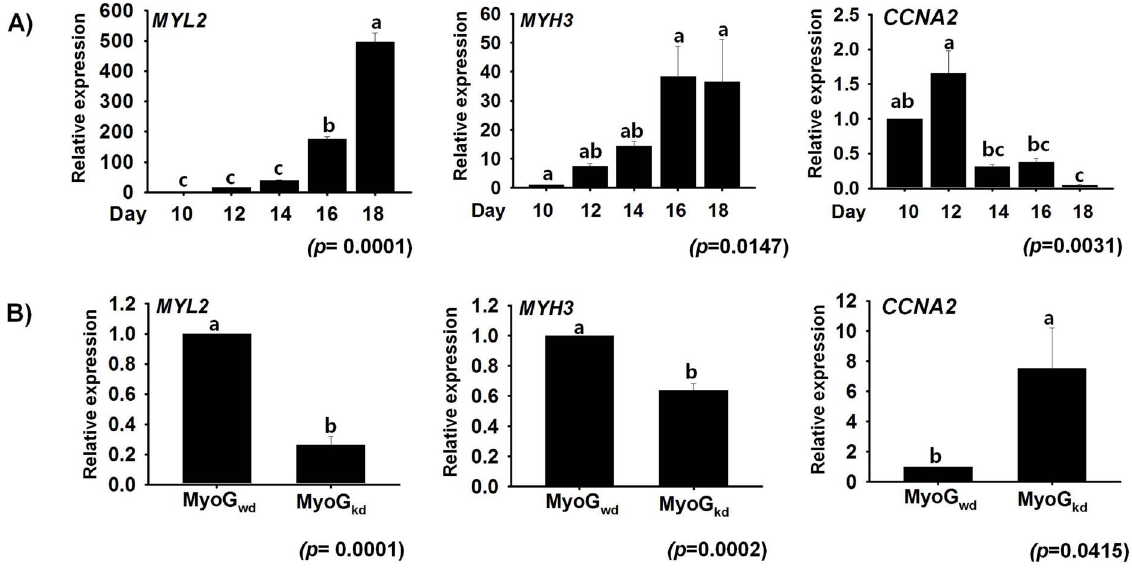
Figure 2. Effect of MyoG kd on MYL2 , MYH3 and CCNA2 genes. A ) Time course study of mRNA expression of MYL2 , MYH3 and CCNA2 during MSCs differentiation. Cells cultured in differentiation media showed gradual increase in MYL2 and MYH3 expression until Day 18, but transient increase of CCNA2 at day 12 decreased at later stage of myogenesis. B ) Evaluation of MYL2 , MYH3 , and CCNA2 gene expression by real time RT-PCR in MyoG kd cells. Decreased MYL2 and MYH3 gene expression and increased CCNA2 expression was observed in MyoG kd cells relative to MyoG kd cells. Day 10 and MyoG wd represents control, respectively (mean 6 S.D., n=3). p -value indicates the statistical significance of the data and different letters (a, b and c) in graph show significant differences among groups.